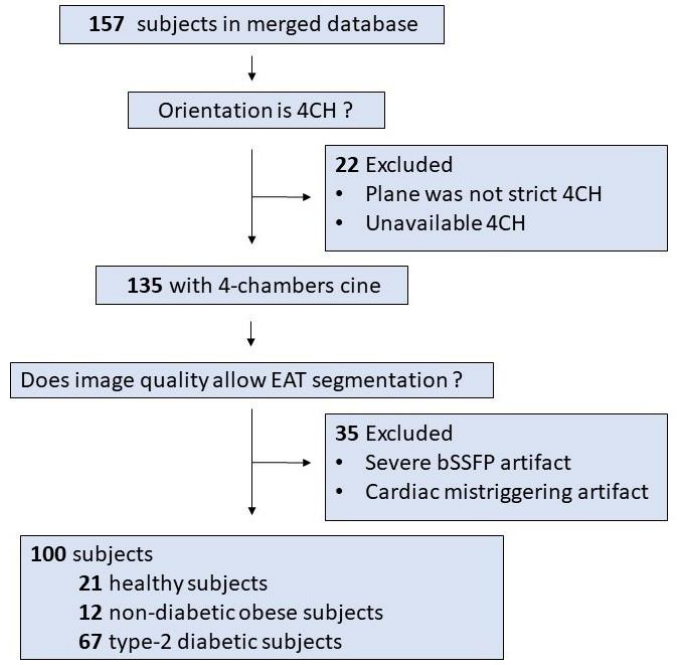
Figure 1. Overview of the study design.